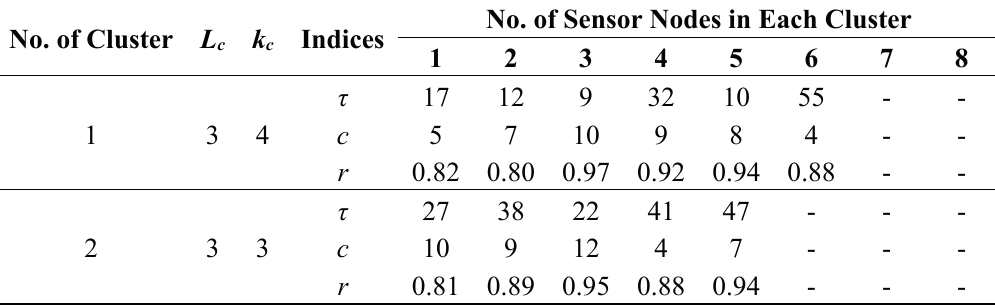
Table 2. Parameters of clusters and sensor